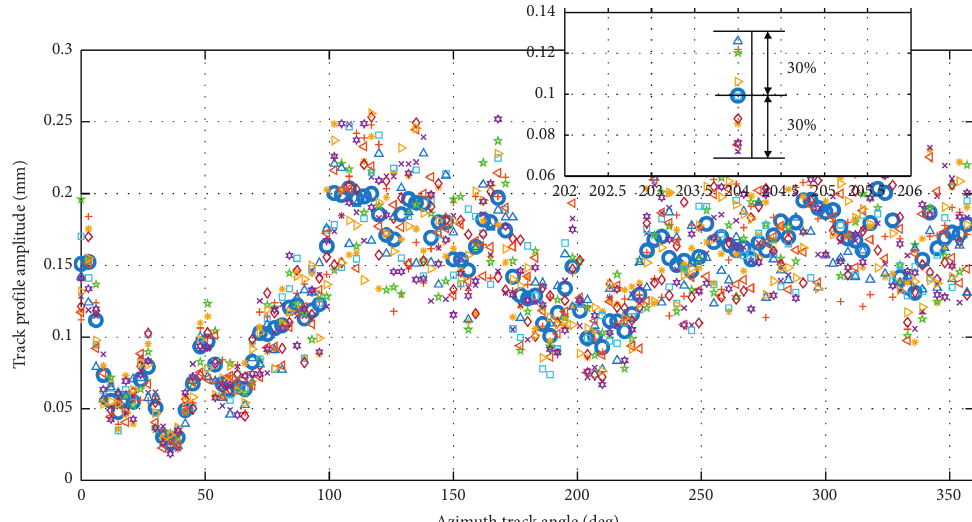
Figure 16: The assumed azimuth track profile distribution with a 30% deviation compared to the original raw data. Table 1: The summary of the RMS value for different support numbers.